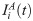
(A) Illustration of input similarity ρsame for which the first Nsame neurons receive identical direct inputs IiA(t) and IIB(t). Also depicted is partial readout dimension Nr under two types of readout orderings: ordered and random, see text for details. (B) Scatter plot of classification performance P of surrogate population vs. network for a range of parameters ρcorr, ρsame and Nr, for both ordered and random readouts (same data as (E)). (C) P for network (black) and surrogate population (green) as a function of Nr with ordered readouts, for ρcorr = 0, ρsame = 0.5. Red dashed line indicates Nr = Nsame. (D) P for network (black) and surrogate population (green) as a function of Nr with random readout, for ρcorr = 0.9, ρsame = 0. For (C) and (D), shaded areas show one one standard deviation (see sampling details below). (E) Color plot of P as a function of ρsame and ρcorr for Nr = N/4. Top row: ordered readouts (dashed line indicates Nr = Nsame). Bottom row: random readouts. First column: network. Second column: surrogate population. For all P values shown, quantities were sampled over 20 repeated simulations where networks, inputs and Tempotron training were reprocessed. N = 500, K = 20.